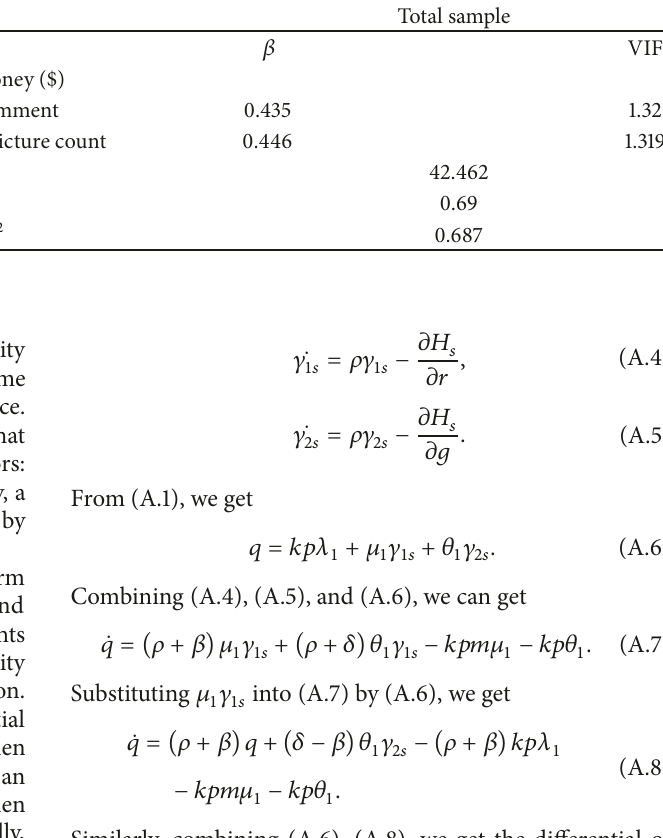
Table 4: Results of regression